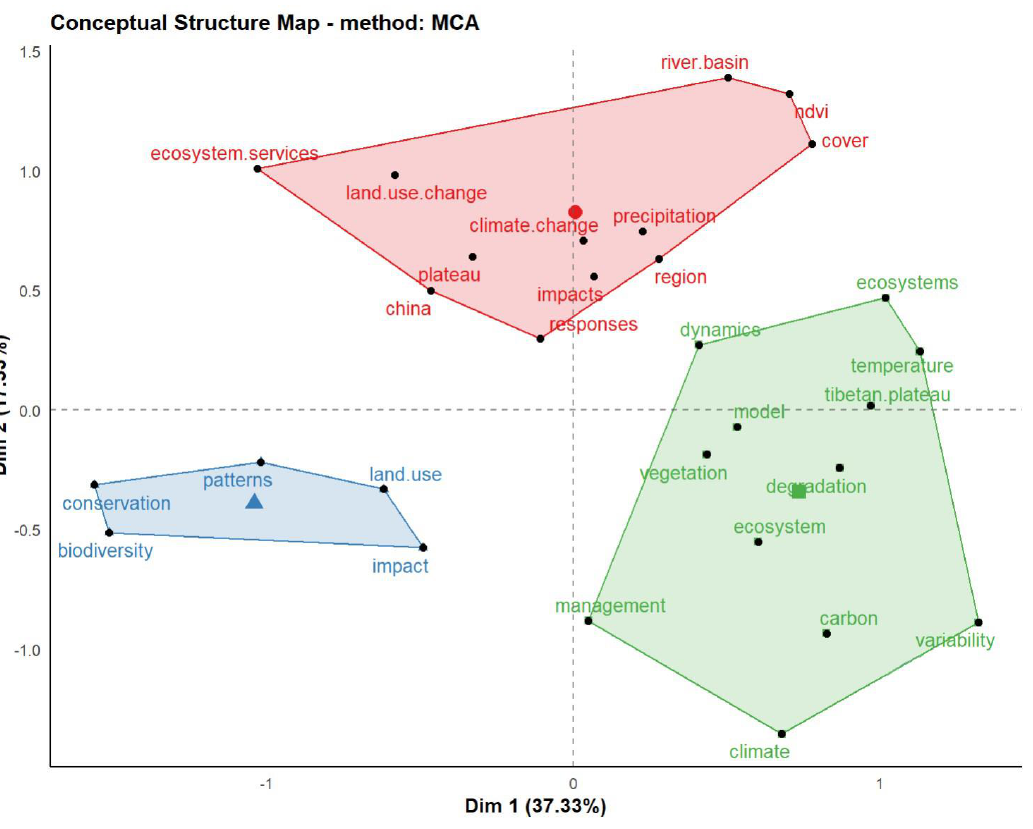
Figure 10. Hierarchical cluster analysis of keywords relating to the ecological and environmental effects of land use and cover changes (LUCC) on the Qinghai – Tibetan Plateau (QTP).